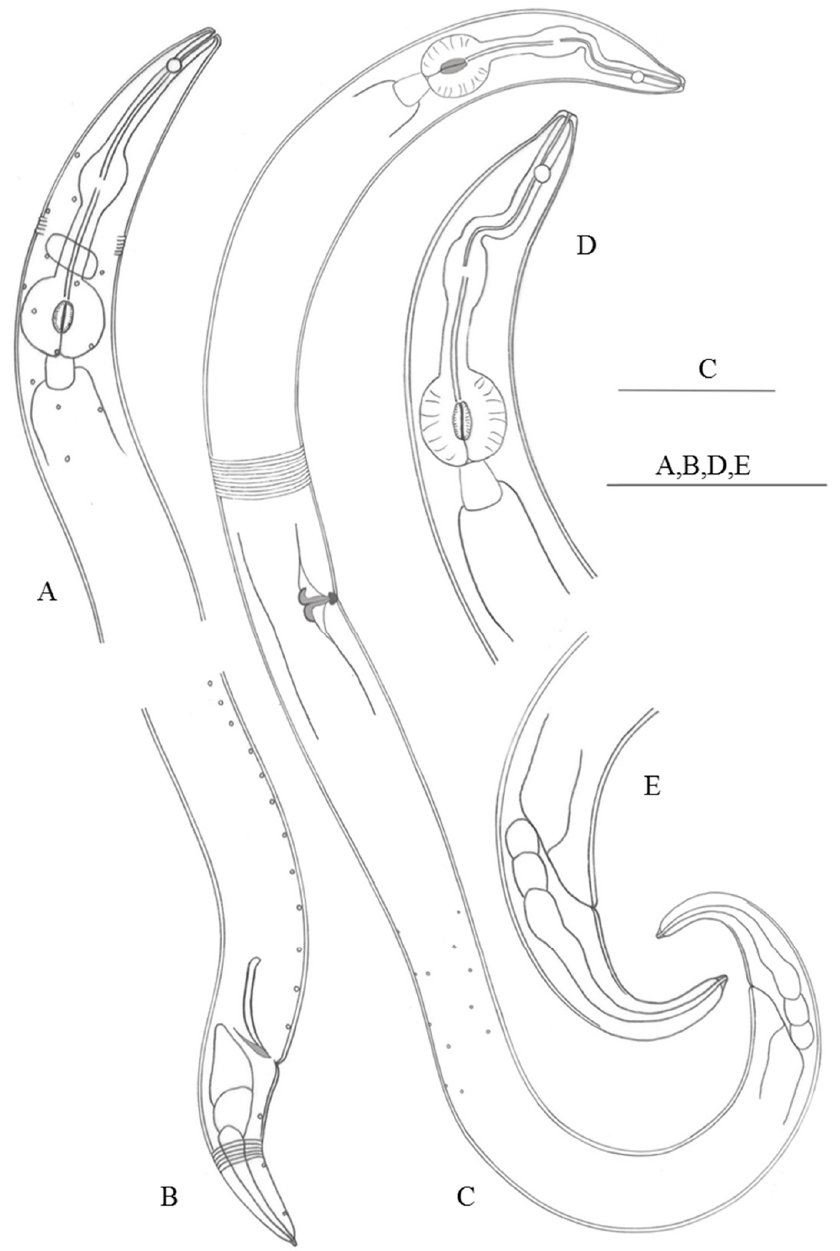
Figure 3. Haliplectus futianisus sp. nov. ( A ) lateral view of male head end; ( B ) lateral view of male tail region; ( C ) lateral view of female total body; ( D ) lateral view of female head end; ( E ) lateral view of female tail region. Scale bars: ( A – E ) = 50 µm.